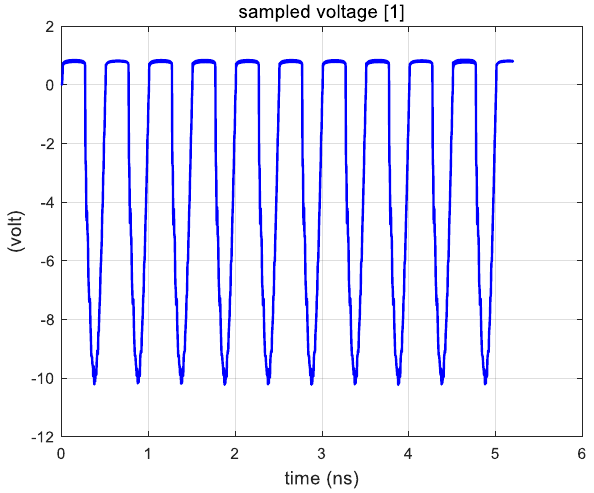
Figure 14. Results for the traditional equivalent circuit method.